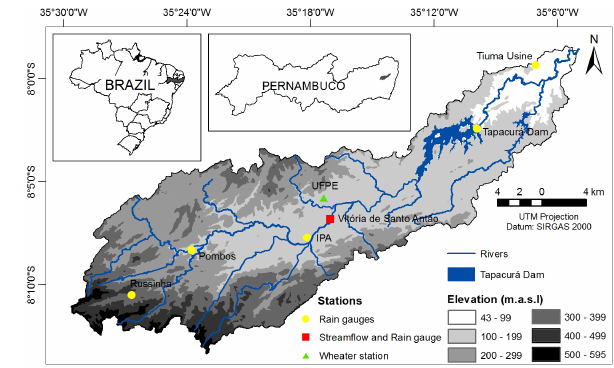
Figure 1. Map showing the location of the study area in Brazil, streamflow gauge and rain